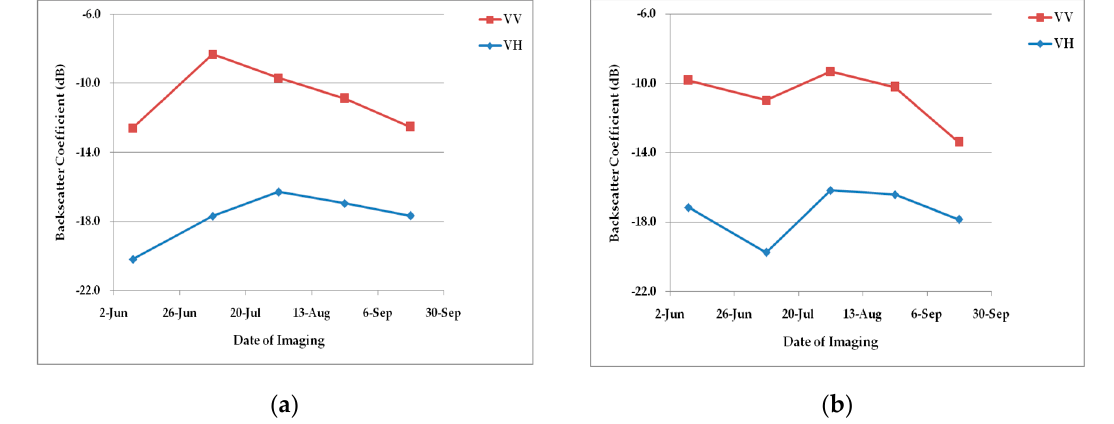
Figure 4. Temporal backscatter profiles of Rice subclasses at both polarizations: ( a ) Rice A; ( b ) Rice B. Data points correspond to Sentinel-1A images of Shanghai acquired on 9 June, 8 July, 1 August, 25 August and 18 September in 2015, respectively.